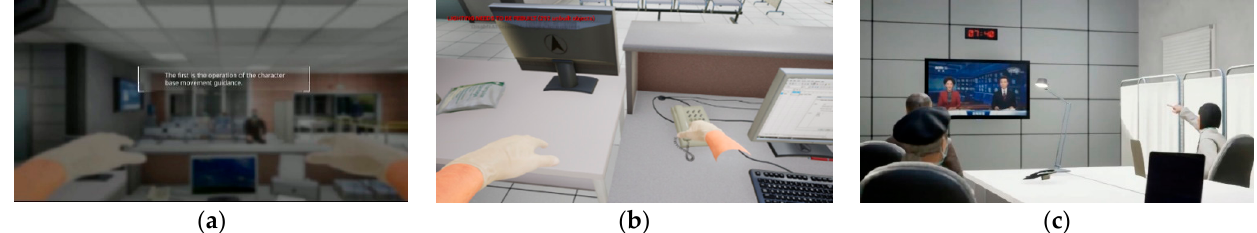
Figure 9. Tutorial Module Implementation: ( a ) Movement Tutorial [9]; ( b ) Tool Interaction Tutorial [9]; ( c ) New Case Response [9].